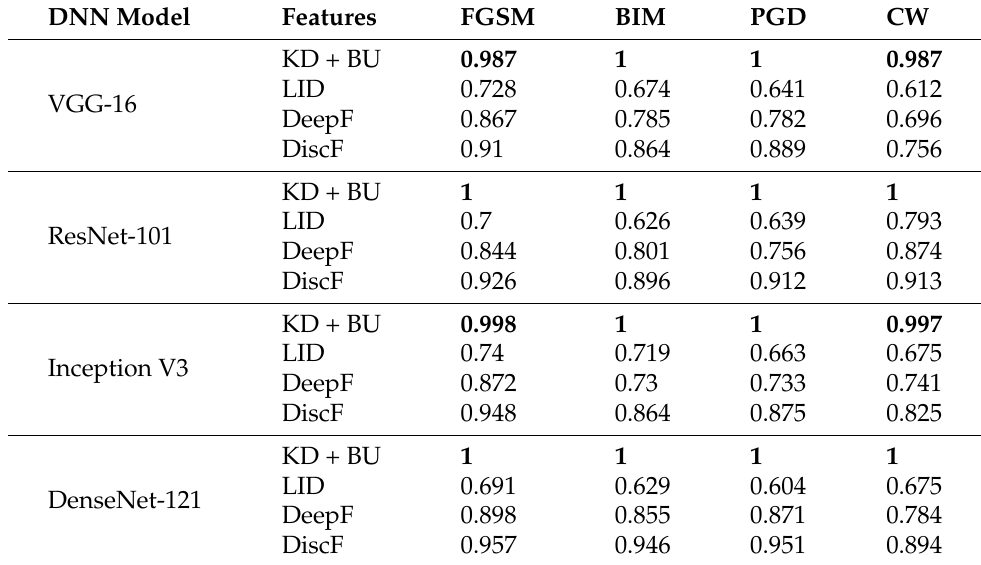
Table 4. Adversarial sample detection results for multi-class DNN models using different features.